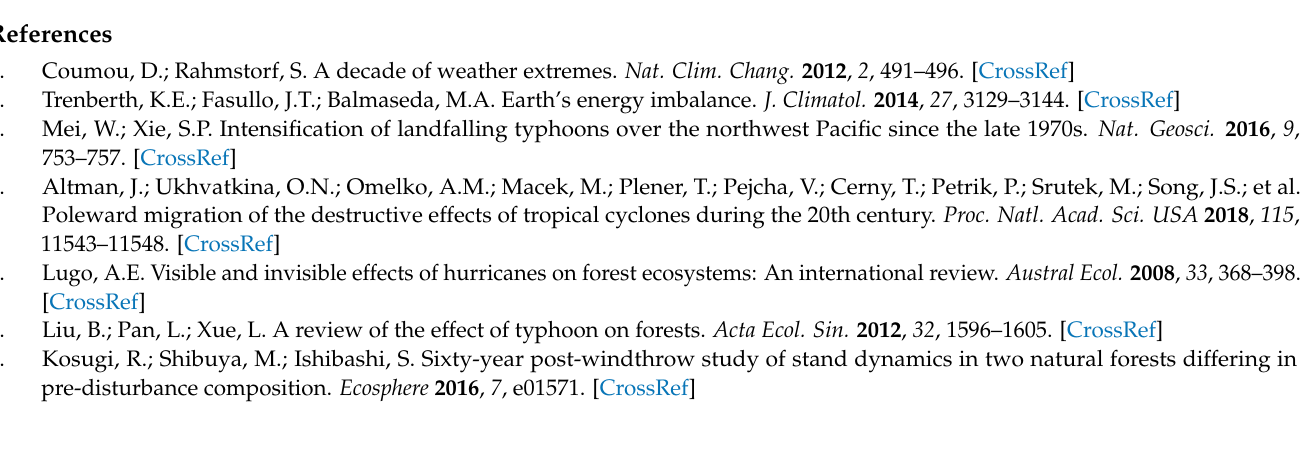
regressions; Figure S1: CCA ordination diagrams of temporal shifts; Figure S2: CCA ordination diagrams of vegetation change; Figure S3: Photographs of disturbed stands of Abies koreana